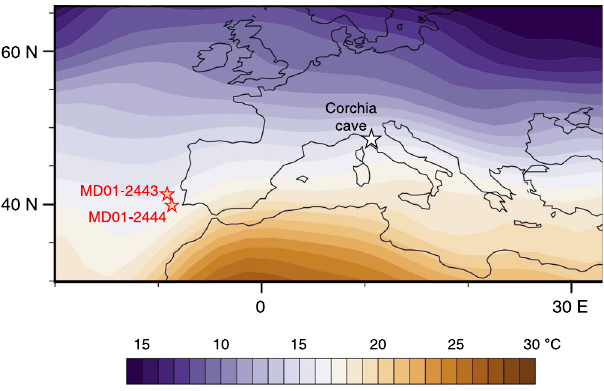
Fig. 1 Mean annual regional air temperatures and study site. Location of Corchia Cave (Italy) and the two Iberian margin ocean-coring sites MD01- 2443 and MD01-2444. The coloured contouring is the mean annual air temperature fi eld at 1000 mbar for the period 1981 – 2010. Image is provided by the NOAA-ESRL Physical Sciences Laboratory, Boulder, Colorado, from their Web site at